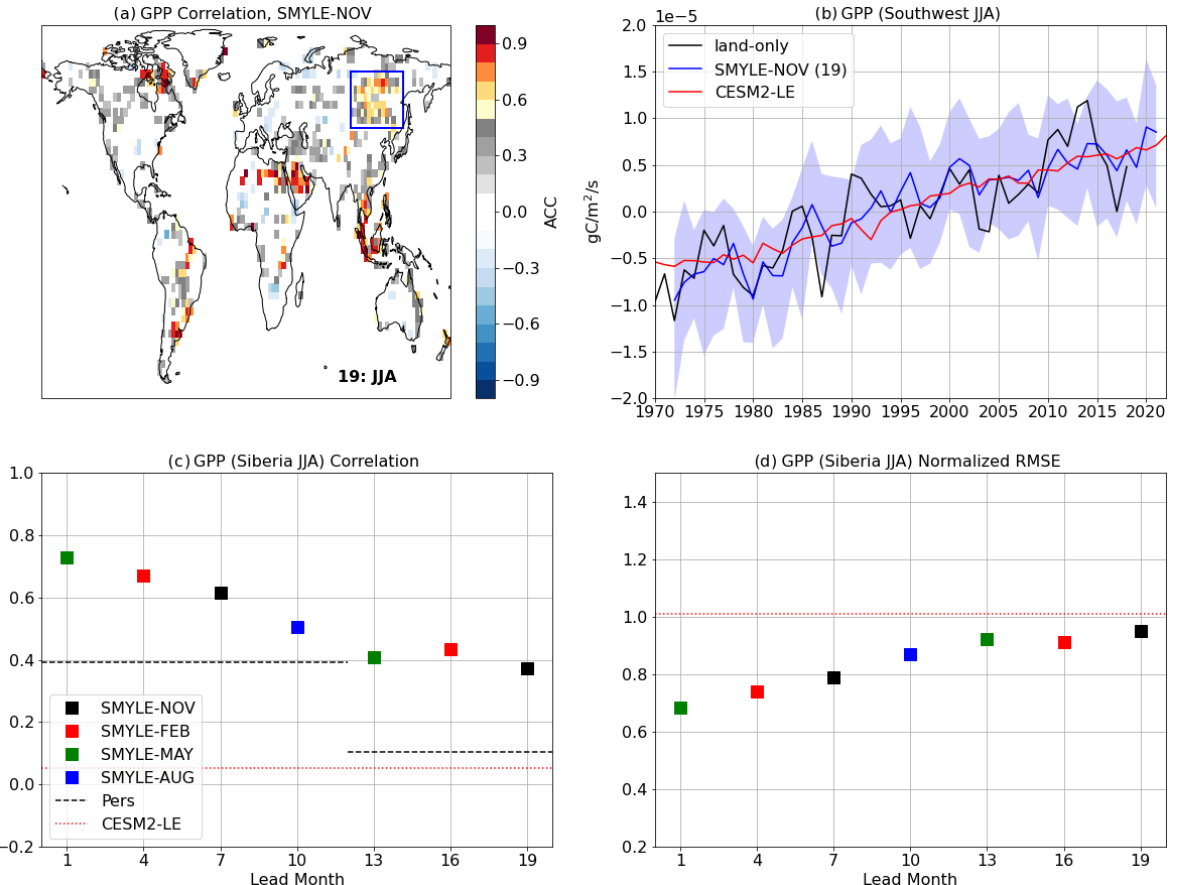
Figure 11. (a) ACC map for gross primary productivity (GPP) in boreal summer (JJA) at lead month 19 (from SMYLE-NOV). The blue box (45–67 ◦ N, 92–137 ◦ E) defines a “Siberia” region. (b) Time series of raw Siberia JJA GPP (in units of gCm − 2 s − 1 ; anomalies from 1972–2018 climatology) from land-only simulation (black), SMYLE-NOV (blue; lead month 19 with SMYLE ensemble mean/range given by line/shading), and CESM2-LE (red; 50-member mean). (c, d) ACC and normalized RMSE scores for JJA GPP over the Siberia region. Time series were detrended prior to skill score analyses shown in panels (a) , (c) , and (d) , but panel (b) shows the non-detrended data. Dashed lines in panel (c) show persistence forecast scores computed as the lag autocorrelation of detrended JJA GPP from the land-only simulation, and red dotted lines in panels (c) and (d) give the CESM2-LE scores (which are independent of lead